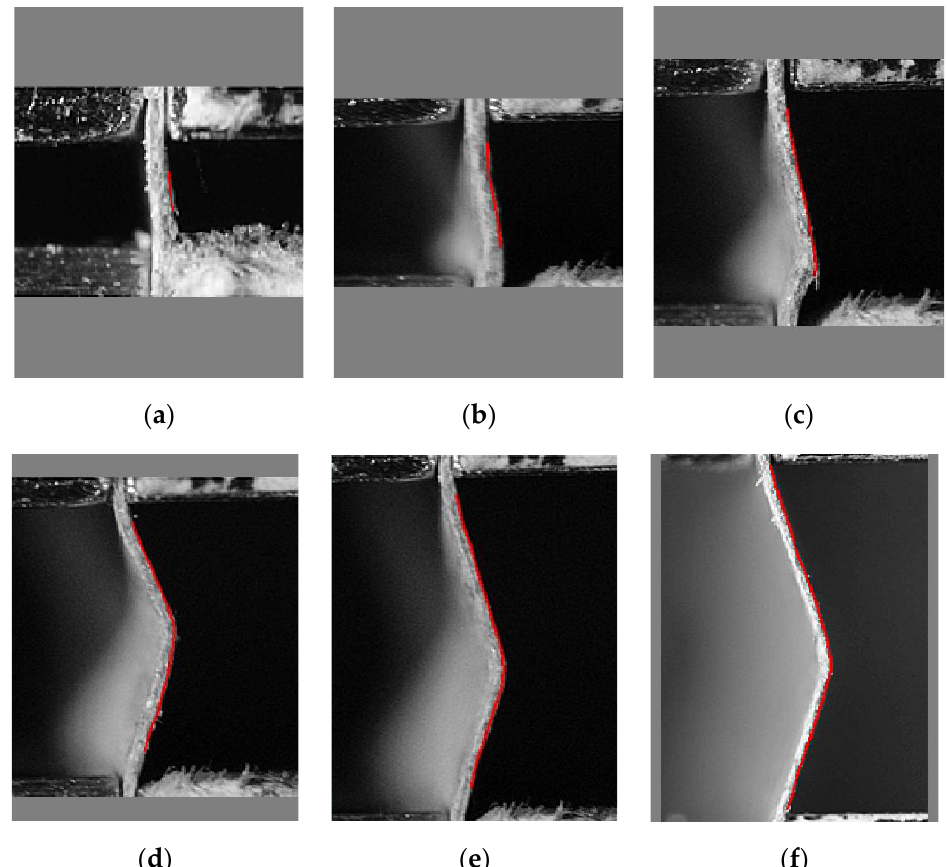
Figure 14. Shape of the edges of the compressed samples at the time of destruction for the connection length: ( a ) 0.7 mm, ( b ) 1.3 mm, ( c ) 2 mm, ( d ) 3 mm, ( e ) 4 mm, ( f ) 5 mm.